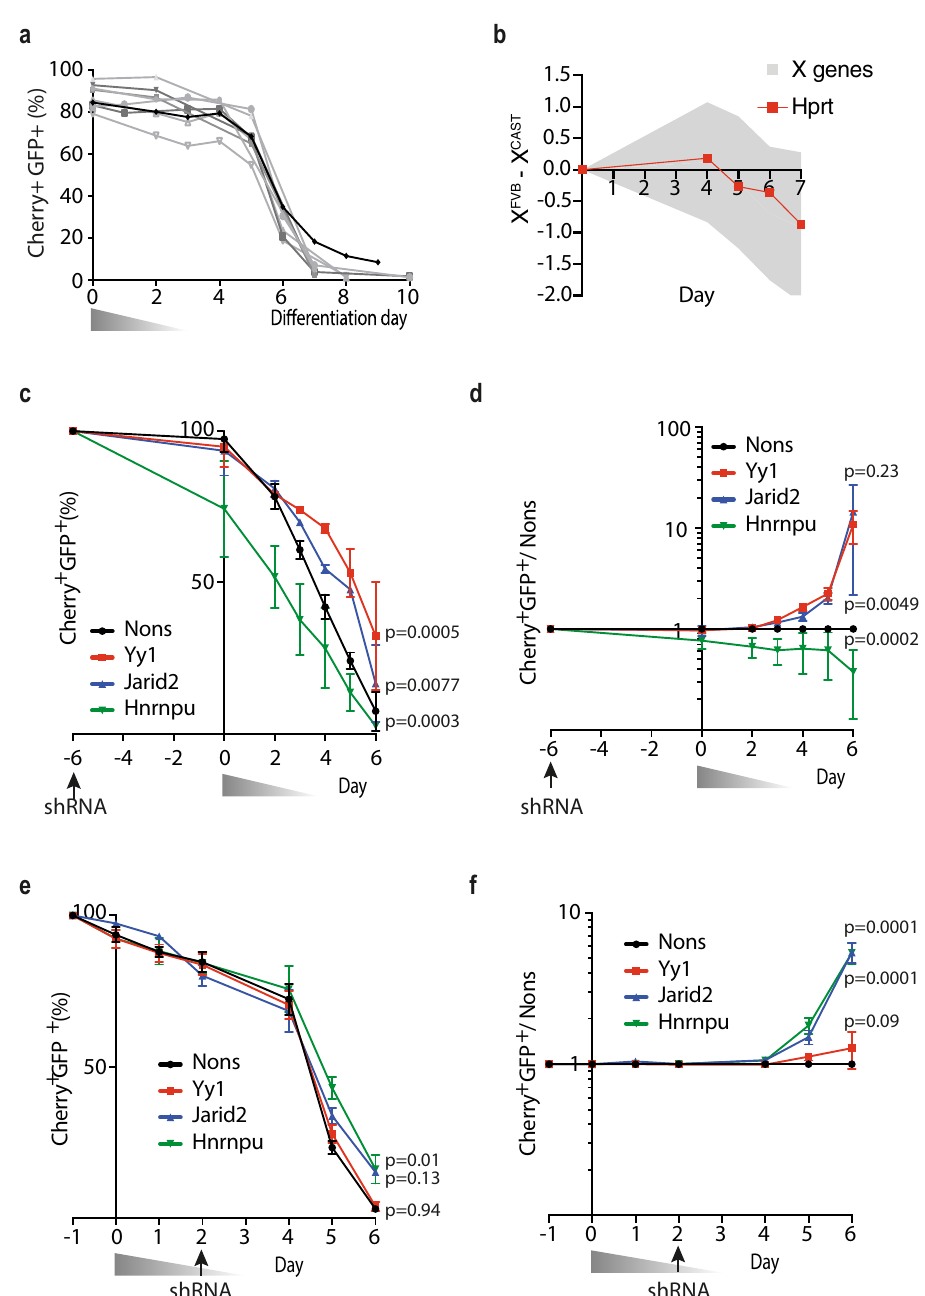
Fig. 4 Xmas mESCs detect impaired XCI during differentiation. a Flow cytometry data showing the kinetics of the fl uorescent reporter alleles during differentiation and XCI of Xmas mESCs for multiple cell lines ( n = 9 independent replicates). The triangle represents weaning from 2i to differentiation media in 25% increments over 3 days. b RNA-seq timecourse data from differentiating X FVB X CAST mESCs showing the ratio of X FVB gene expression compared with the X CAST (X FVB — X CAST log 2 ). Hprt expression is represented as a red line and other X-linked genes as grey shade. c – f Flow cytometry data showing the kinetics of the fl uorescent reporter allele expression changes during differentiation and XCI of Xmas mESCs. Cells were challenged with shRNAs against the indicated known regulators of XCI or control (Nons) either prior to differentiation depicted as either raw data ( c ) or normalised to Nons ( d ), or during differentiation as either raw data ( e ) or normalised to Nons ( f ). Triangles represent weaning from 2i media into differentiation media and arrows indicate the day of shRNA viral transduction. n = 3 – 6 independent replicates from two independent shRNAs per gene, error bars indicate s.e.m., two-way ANOVA, p value is given for the entire timecourse of that gene knockdown. Source data are provided as a source data fi